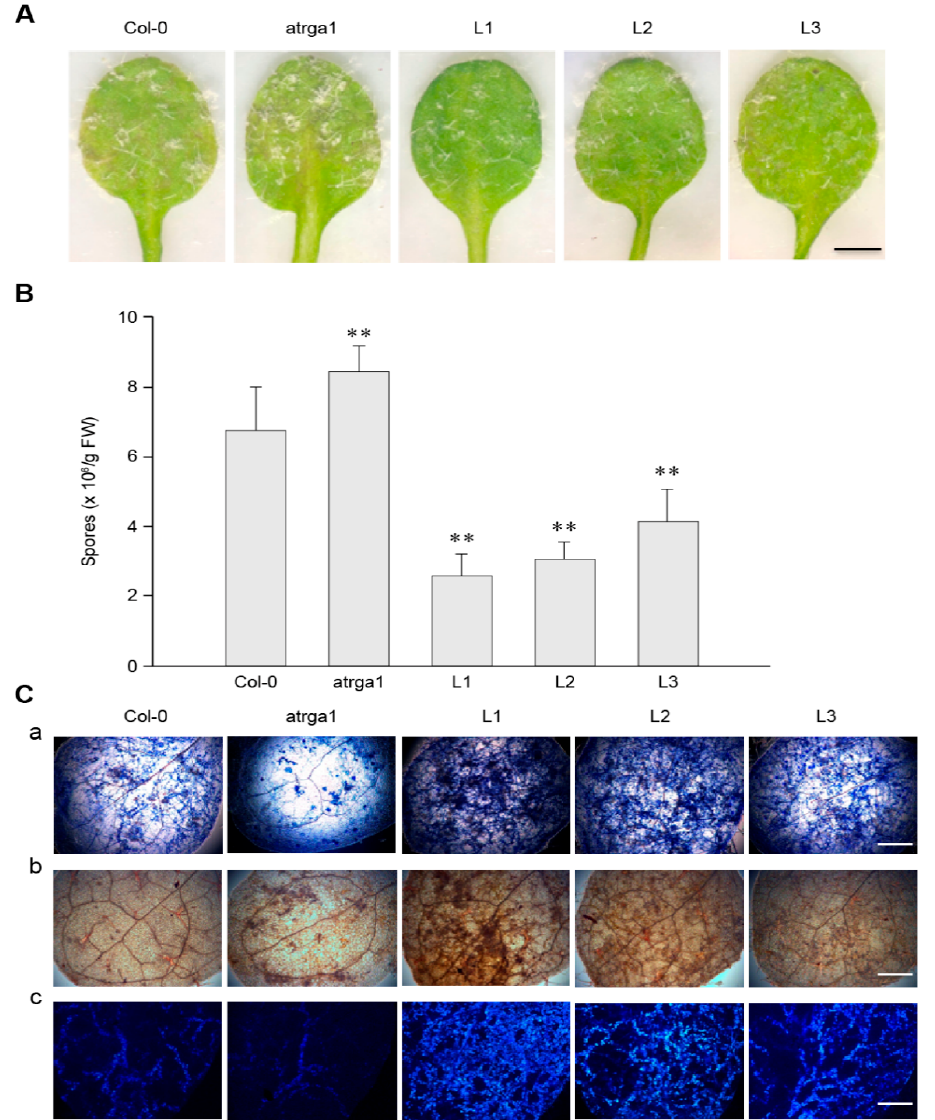
Figure 3. VaRGA1 expression in Arabidopsis improves resistance to Hpa . Transgenic plants (L1, L2, L3), mutants ( atrga1 ), and non-transgenic controls (Col-0) were inoculated with Hpa for the following experiments. ( A ) The symptom of plants infected with Hpa seven days post-inoculation (dpi). Scale bars = 1 mm. ( B ) Biological statistics on the number of spores per gram were assessed at 5 dpi. Data represent mean values ± SD from three independent experiments. Asterisks show a statistically significant difference (** p < 0.01, Student’s t test). ( C ) Histochemical staining was performed to detect cell death, H 2 O 2 accumulation, and O 2– accumulation at 5 dpi with (a) trypan blue, (b) diaminobenzidine (DAB), and (c) Nitro blue tetrazolium (NBT) staining, respectively. Three independent experiments were conducted with 10 leaves in each. Scale bars = 0.5 mm.